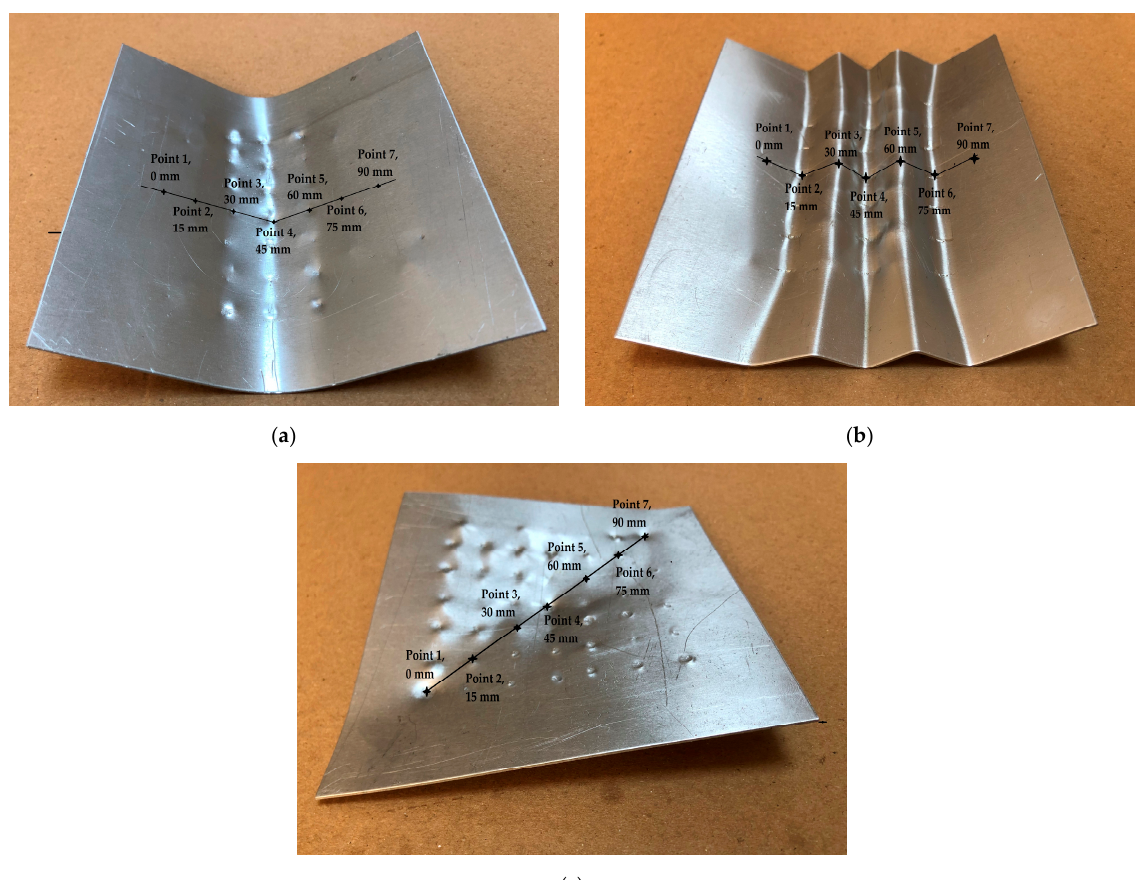
seems to be reliable. The maximum thinning point of form1 is in accordance with the study performed in [21]. In that study, MPF and multi-point forming with individually controlled force-displacement (MPF-ICFD) was performed on 1060 aluminum alloy with 2 mm thickness to give the form similar to form1 in this study. It was concluded that MPF- ICFD proved to generate less thickness variation and thinning. Figure 16. The parts after experiments ( a ) form1; ( b ) form2; ( c ) form3. Figure 16. The parts after experiments ( a ) form1; ( b ) form2; ( c ) form3. Thinning of the sheets on dimple points was also measured in the finite element model and experimental parts. In Deform 3D, slicing tools were used to measure the points on lines in Figure 16. In the experimental parts, a micrometer was utilized to meas- ure thinning on these points. Form1 and form2 lines were constructed from left to right and the line of form3 was along the diagonal. The measured thickness of the experimental and FE analysis parts of 12 mm forming is shown in Figure 17. For form1 and form2, the highest thinning of sheet metal was measured on point 4, the middle point of the lines. On form1, the thickness of the sheet metal part was obtained as 0.432 mm and 0.427 mm for FE and experimental, respectively. Form2 had 0.371 mm and 0.367 mm thicknesses. In form 3, the highest thinning was observed at points 1, 4, and 7 due to the geometry of the 3D free-form surface. The thickness was acquired as 0.413 mm and 0.403 mm for points 1 and 7 and 0.408 mm and 0.402 mm for point 4. Thickness graphs showed similar trends as were seen in load graphs . Therefore, it was considered that finite element modeling Figure 17. Cont